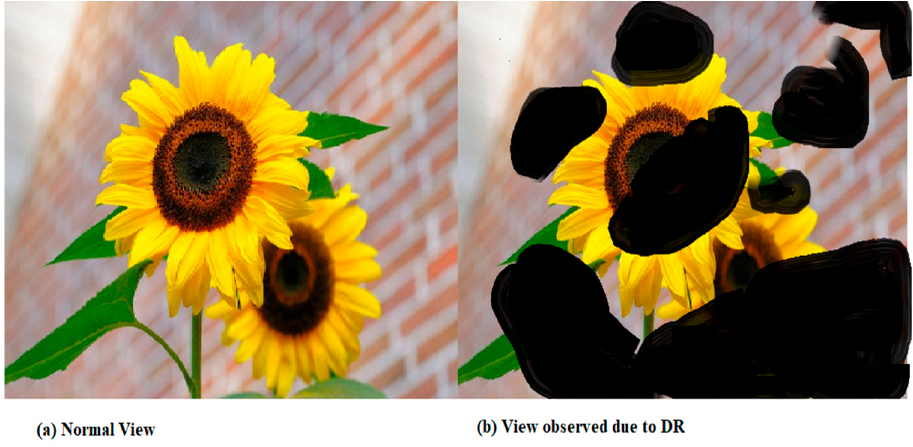
Figure 2. Normal vision and DR